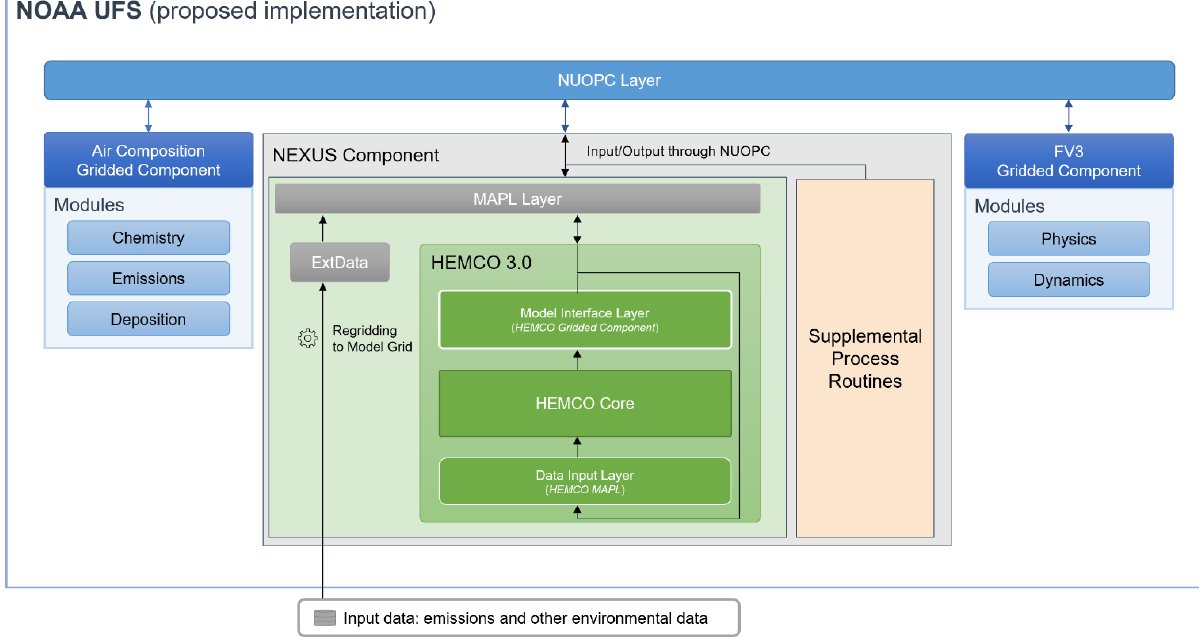
Figure 9. Planned HEMCO 3.0 implementation in the NOAA UFS. UFS is a unified software infrastructure for NOAA forecast models to enable exchange of model components between different application models. HEMCO is planned as the core of the NOAA Emissions and eXchange Unified System (NEXUS) component to serve both emissions and surface exchange (state-dependent emissions, dry deposition, and two-way exchange) as part of UFS. HEMCO operates under the MAPL coupling framework in the same way as in the NASA GEOS ESM (Fig. 6) but reads independent environmental data for use in surface exchange calculations. Supplemental process routines provide the surface exchange calculations. NEXUS operates under the NUOPC coupling framework to provide emissions and surface exchange information to other UFS